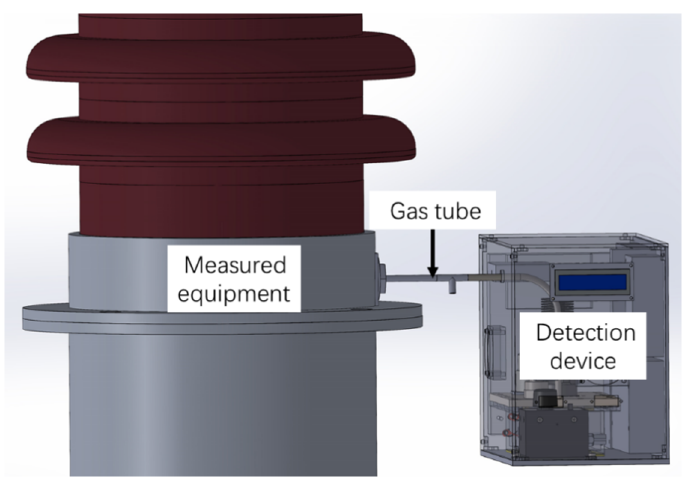
Figure 11. Schematic diagram of the connection between measured equipment and the proposed SO 2 detection device.